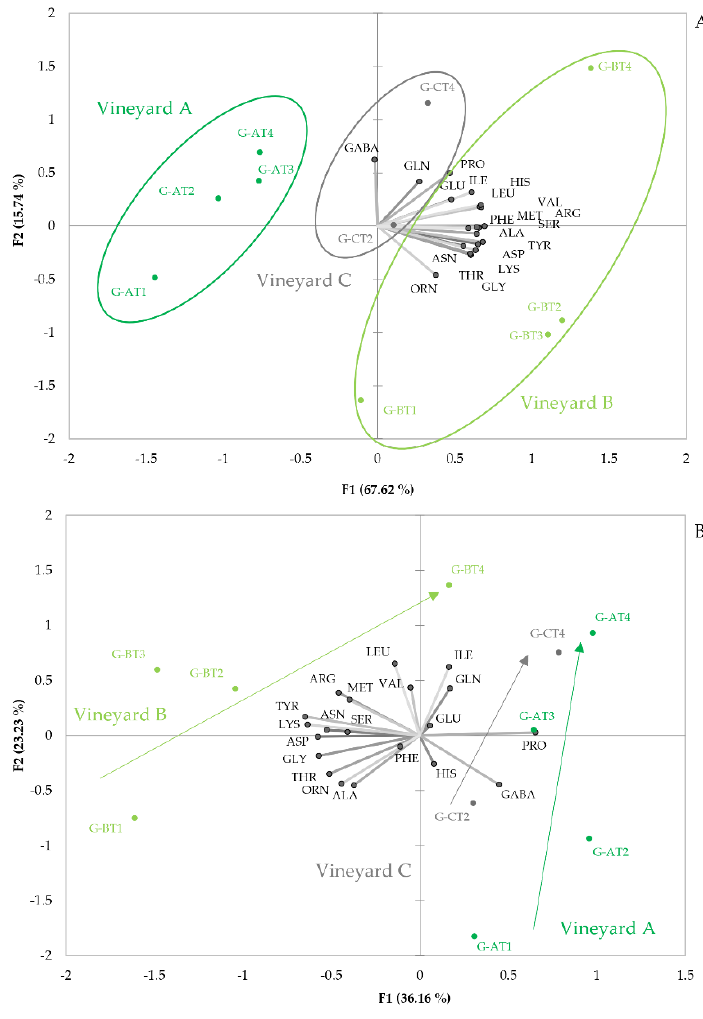
Figure 1. Amino acid variability with maturation in the three different vineyards sampled in the study. The plots give the projections of the sample scores and variable loadings in the planes formed by the two first Principal Components obtained in the PCA study carried out with amino acid data from 10 different mistelles made with representative grape samples from different ripeness and three different vineyards. ( A ), absolute data; ( B ), relative data (amino acid concentration in